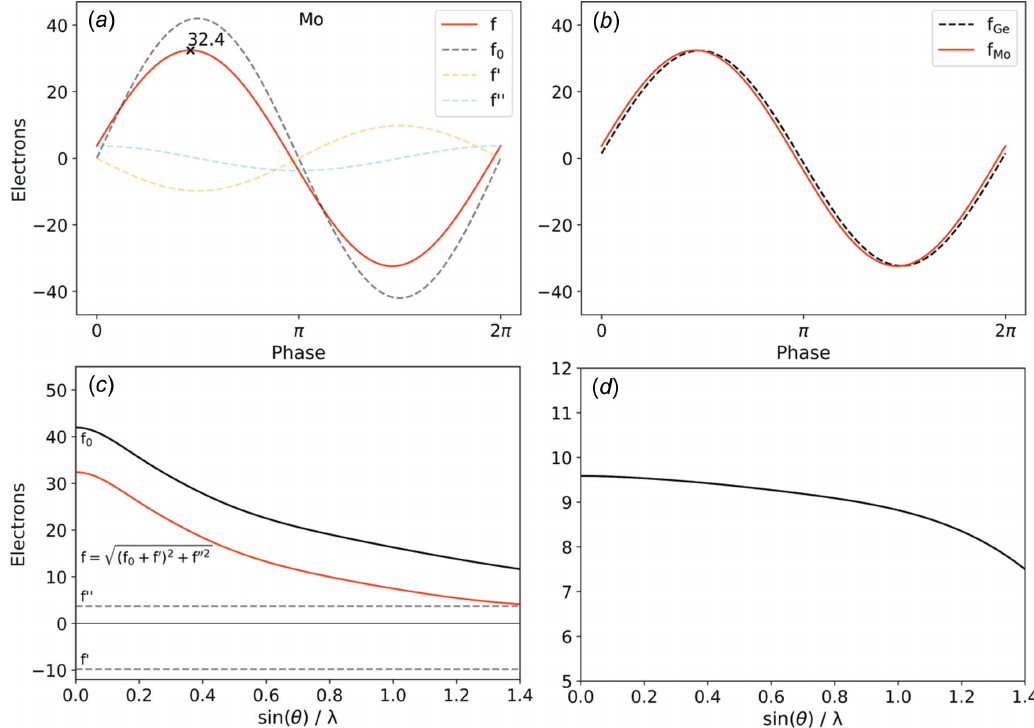
Figure 1 Dispersion corrections for the phase-dependent f (000) for ( a ) molybdenum and ( b ) comparison to germanium at 20 000 eV; ( c ) effect of f 0 and f 00 on the atomic form factor f 0 ; ( d ) resolution-dependent difference between f 0 and f